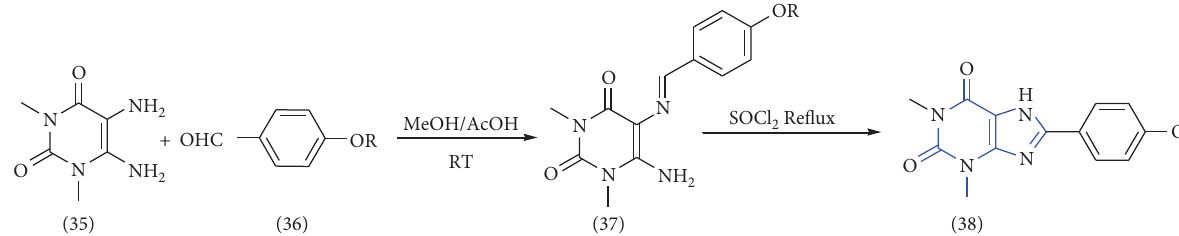
Reagents and conditions: i) EDAC, dioxane: H 2 O (1:1); (ii) Na OH (aq), refux (iii) CH 3 I or C 2 H 5 I, K 2 CO 3 , DMF, ethanol or Scheme 4: Synthetic pathway to xanthine derivatives.